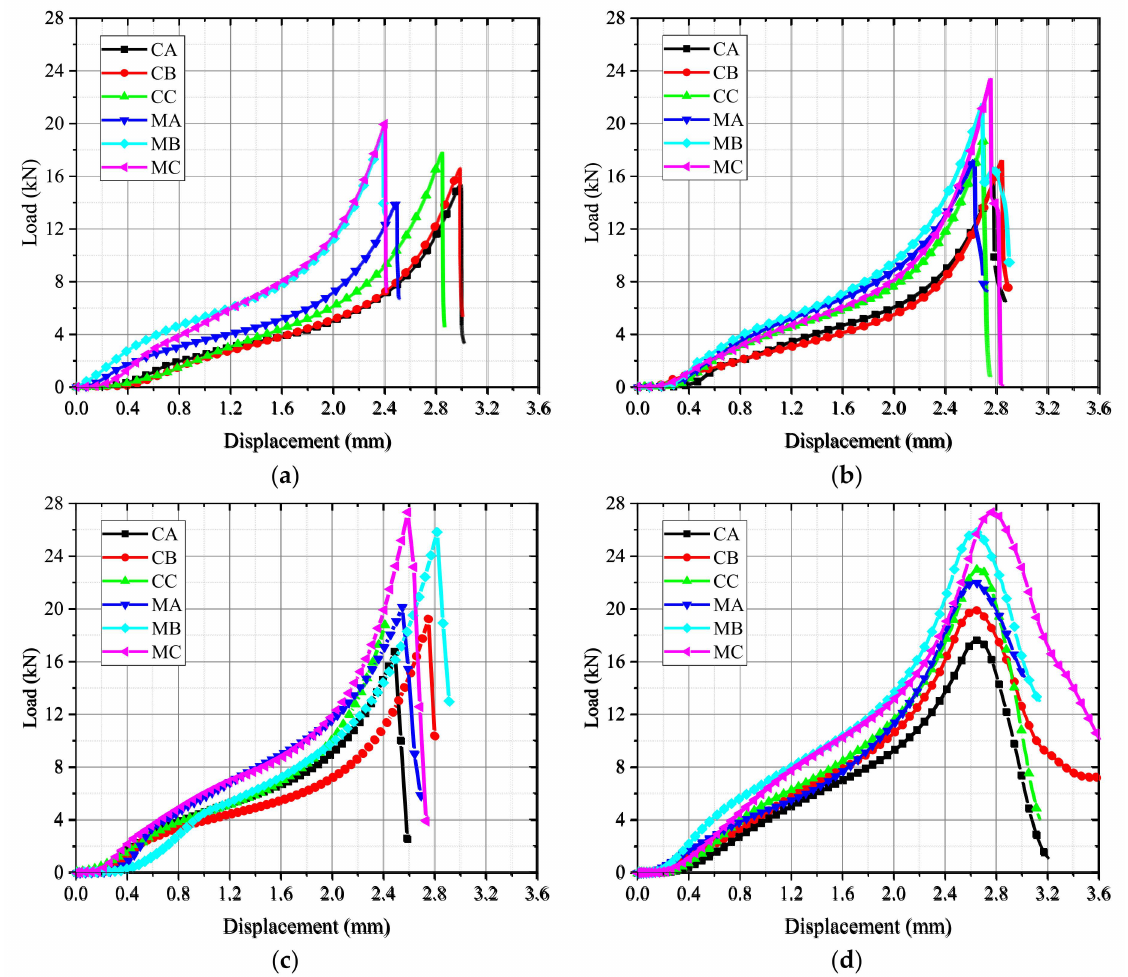
Figure 4. Load–displacement curves of splitting tensile test under different loading rates: ( a ) 0.2 mm/min; ( b ) 0.02 mm/s; ( c ) 0.2 mm/s; ( d ) 2